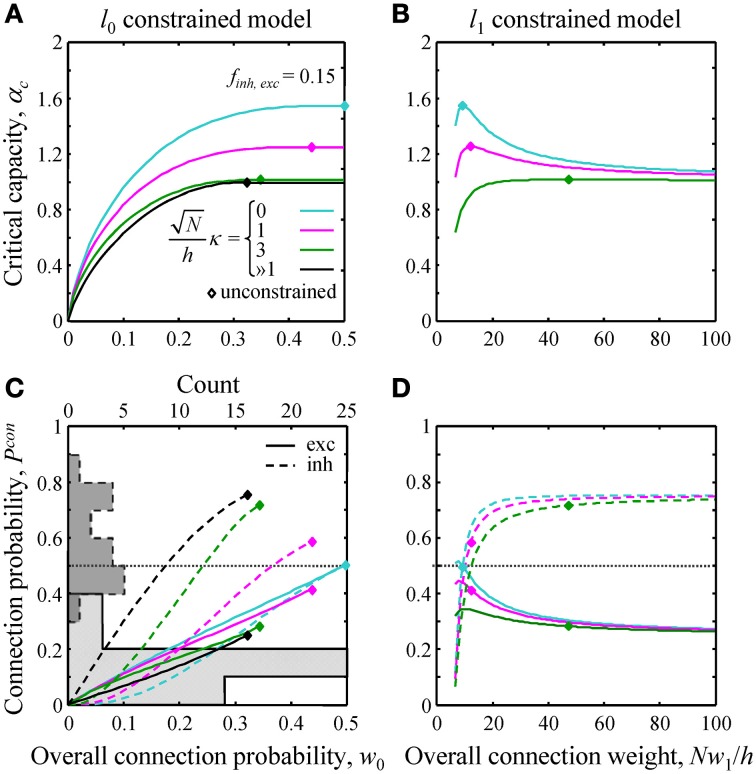
Effects of
l0 and
l1 constraints on critical capacity and connection probability. (A,B) Critical capacity of the l0 and l1 constrained models plotted as a function of the constraints, w0 and Nw1/h. Diamonds denote the corresponding value of the critical capacity in the unconstrained model. The critical capacity is at its maximum when w0 and w1 match the corresponding values calculated for the unconstrained model. (C,D) Excitatory (solid lines) and inhibitory (dashed lines) connection probabilities in the l0 and l1 constrained models. Gray histograms in (C) represent excitatory (solid outline) and inhibitory (dashed outline) connection probability data from a large set of experimental studies (see Text S1 for details). Note that the histogram counts are shown at the top of (C).